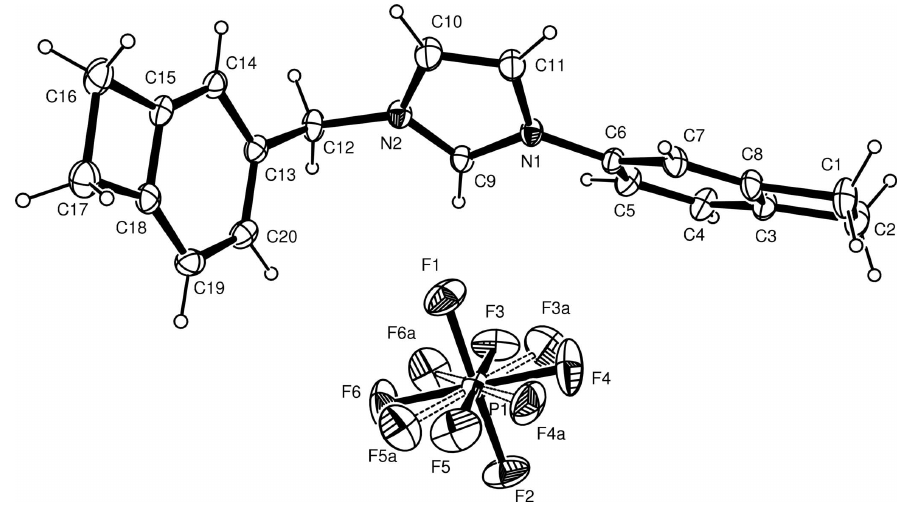
The molecular structure of the title compound, showing 30% probability displacement ellipsoids and the atomic